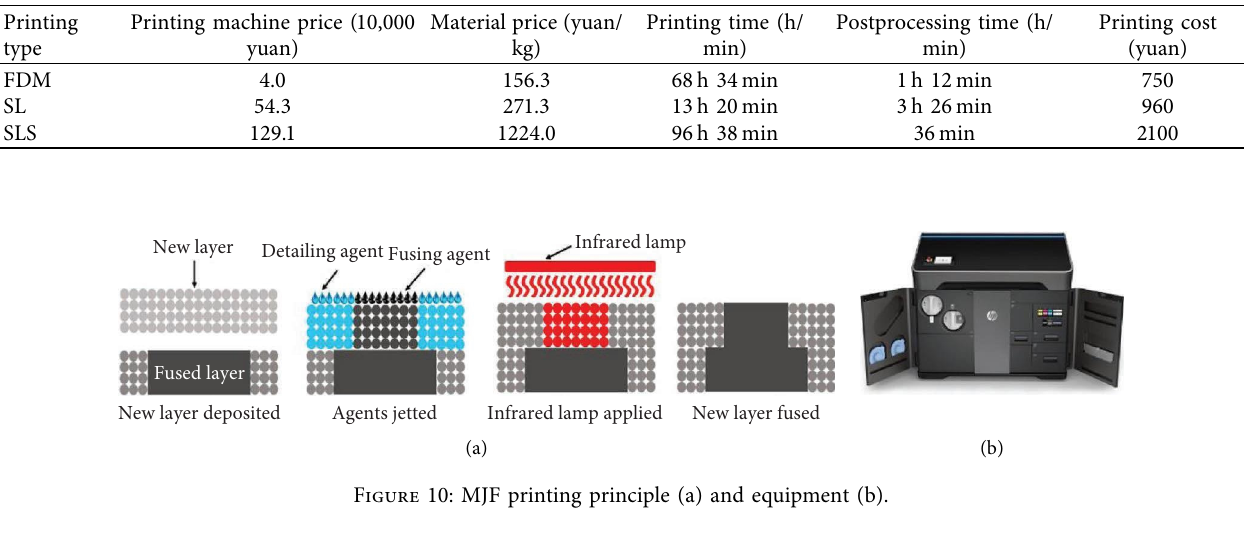
Table 2: Tree types of 3D printing production process cost analysis.